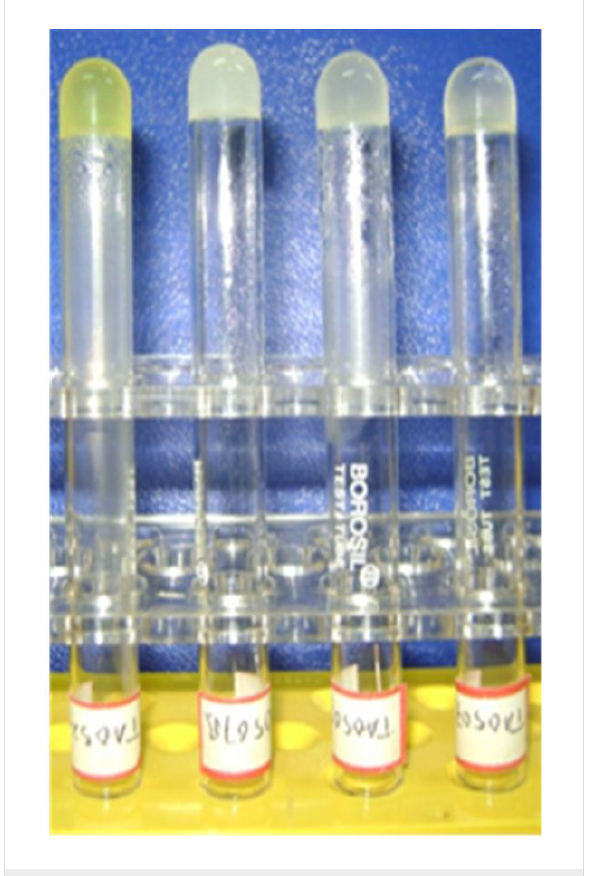
Figure 1: Photomicrographs of the organogels (from left to right: nitrobenzene gel of DBUAMC 3 ; 1,2-dichlorobenzene gel of DBAMC 6